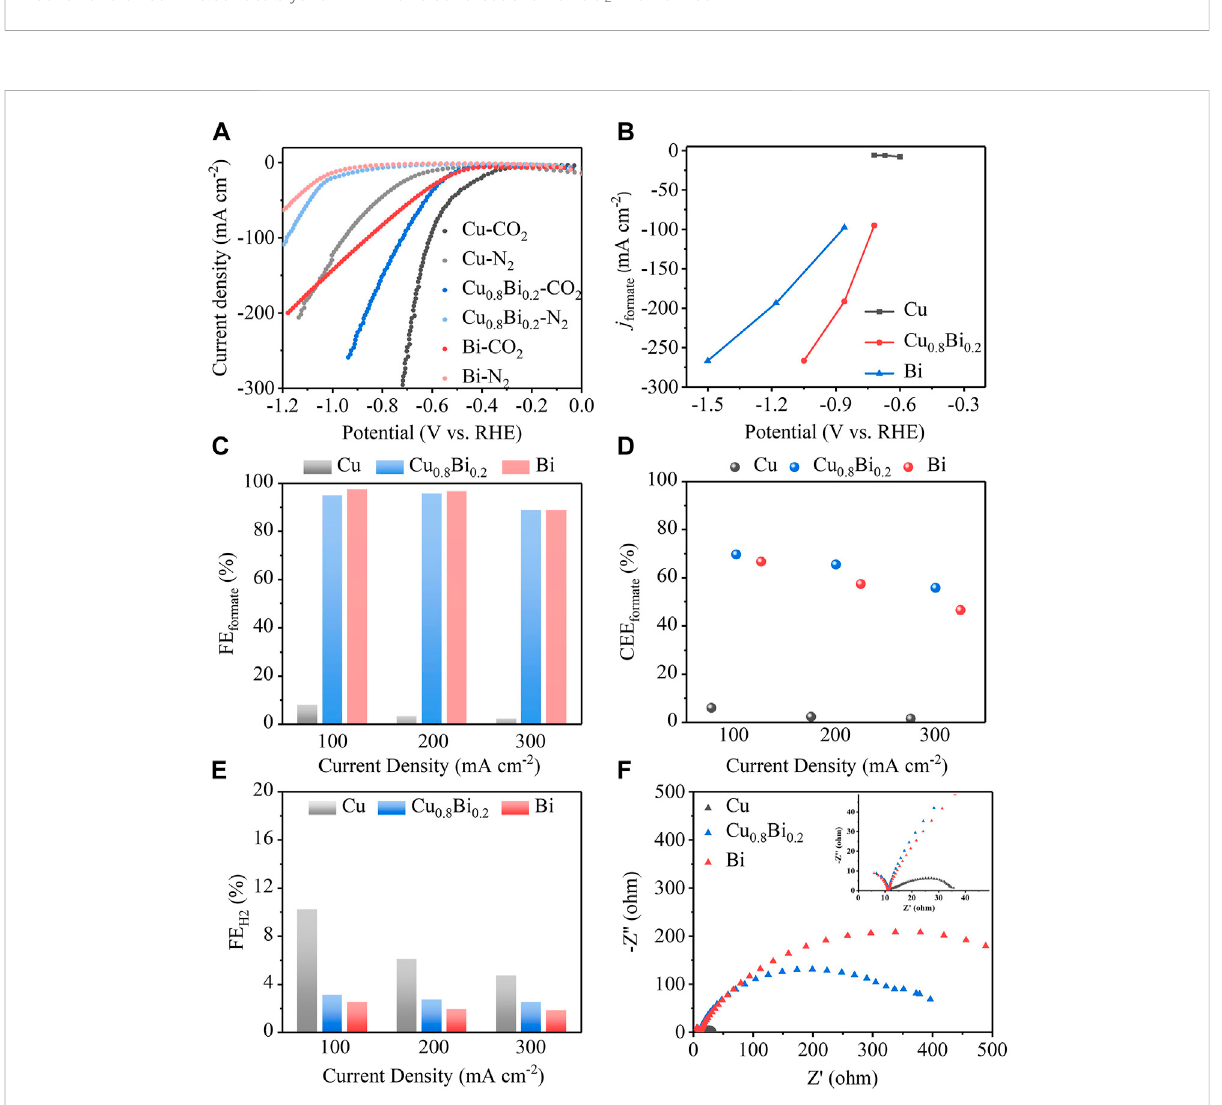
FIGURE 5 (B) The particular current density of formate of Cu (A) The LSV curves under CO 2 or N 2 conditions of Cu 0.8 Bi 0.2 , Cu, and Bi. 0.8 Bi 0.2 , Cu, and Bi. (C,E) The faradaic ef fi ciency of formate and H − 2 . (D) The cathode energy 2 of Cu 0.8 Bi 0.2 , Cu, and Bi at current densities of 100, 200, and 300 mA cm ef fi ciency of formate at current densities of Cu 0.8 Bi 0.2 , Cu, and Bi of 100, 200, and 300 mA cm − 2 . (F) The EIS curve of Cu, Cu 0.8 Bi 0.2 , and